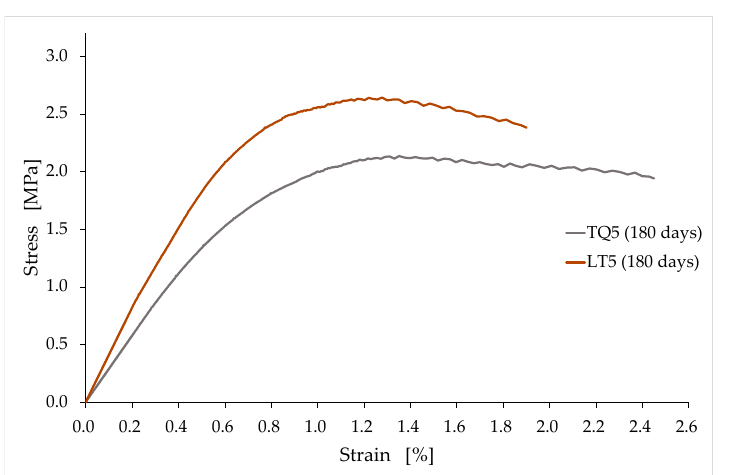
Figure 10. Comparison between the stress/strain curves of the TQ5 specimen and the LT5 specimen.